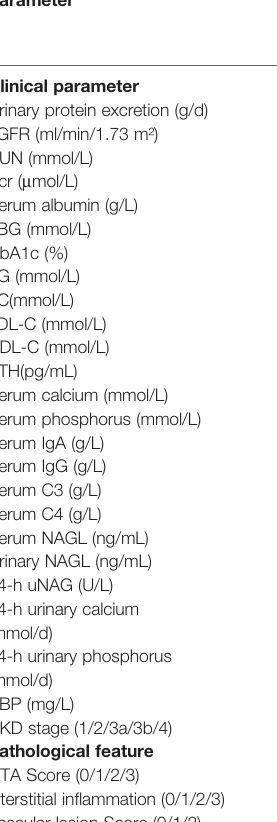
TABLE 4 | Correlations between serum 25(OH)D and clinicopathological parameters.